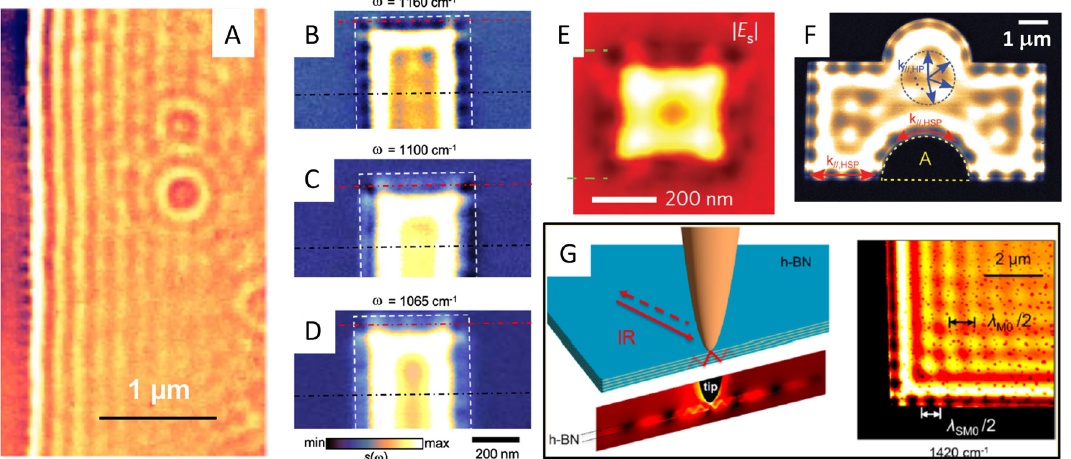
Figure 3: Interior and edge polaritons in van der Waals quantum materials. Panel A: charge transfer plasmon polaritons at the interface of graphene and a-RuCl3 visualized by means of nanoinfrared methods ( ω =898cm − 1 , T =60K).Threetypesofplasmonicfringesareobserved:(i)edgeplasmonpolaritons(darkspotsatalongthephysicalboundary of graphene crystal), (ii) interior plasmon polaritons (oscillating wave pattern emanating from the boundary of graphene on the left), and (iii) defect-launchedplasmonpolaritonsformingcircularpatternsintheinteriorofthesample.AdaptedfromastudybyRizzoetal.[68].PanelsB – D:nano-IRimagingofedgeplasmonsongraphenenanoribbons.WhitedashedlinesmarktheboundariesofthecrosscutGNR.Adaptedfroma study by Fei et al. [126]. Panel E: nanoinfrared image of edge plasmons in a square sample of graphene. Adapted from a study by Nikitin et al. [128]. Panels F: nanoinfrared images of edge phonon polaritons in the 25-nm-thick slab of hBN. Adapted from a study by Dai et al. [114]. Panel G: edge and interior phonon polaritons in a 40-nm-thick slab of hBN